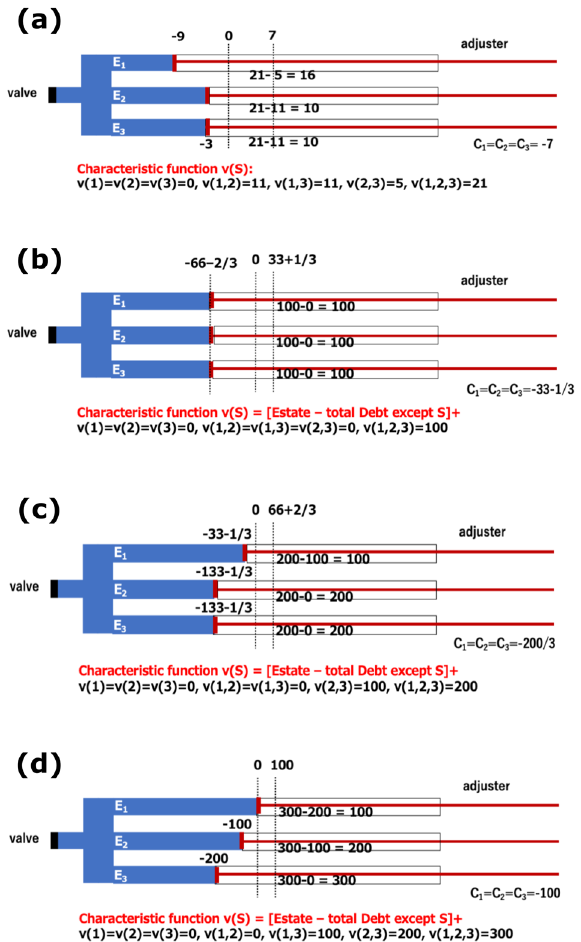
Fig. 5 Physical solutions for pro fi t distribution in a game of characteristic function form. a The taxi problem: Initial liquid levels were E 1 = − 9, E 2 = − 3, E = − 3, C = − 7, C = − 7 and C = − 7, respectively (see ‘ Method ’ ). Owing to gravity (stand it vertically), the system could reach equilibrium state E 3 1 2 3 =